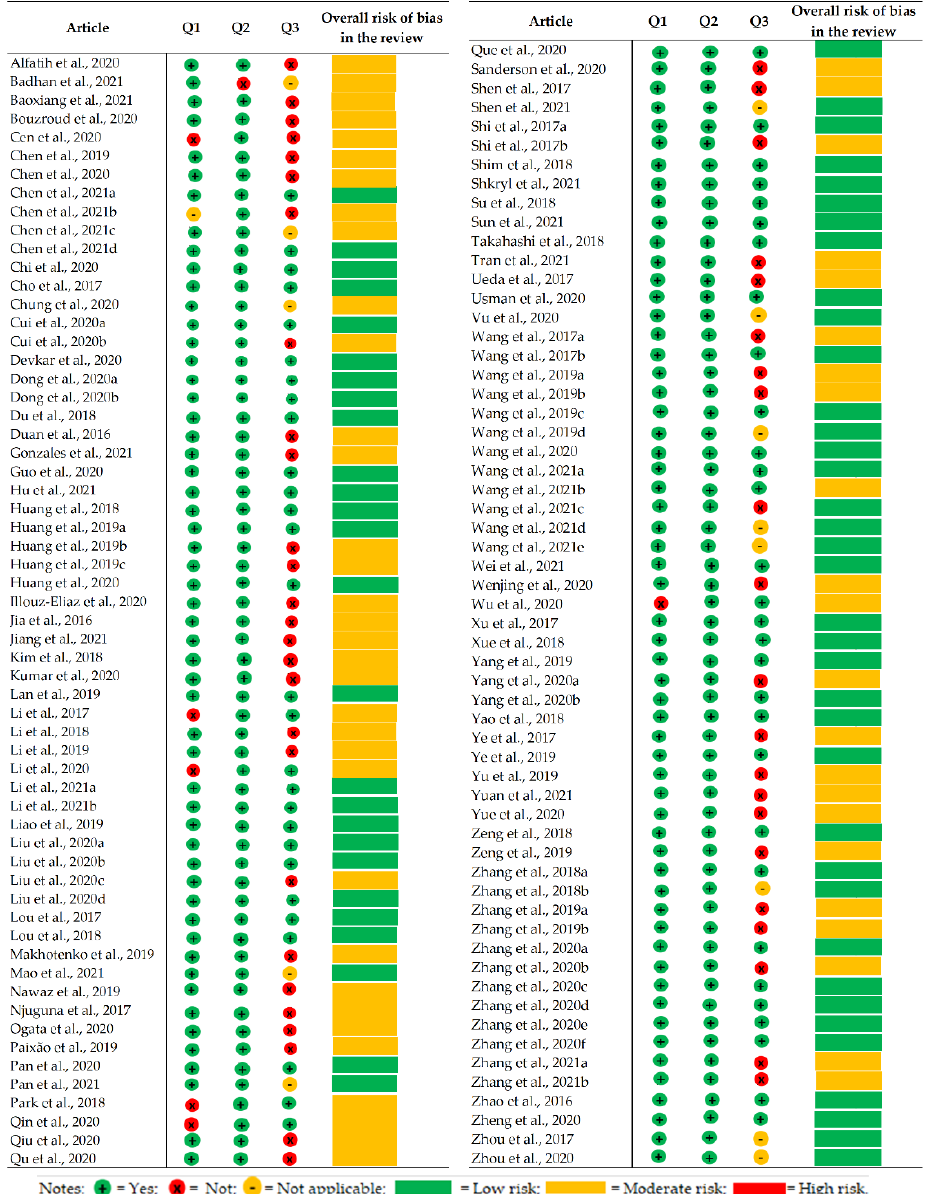
Figure 11. Summary of the risk of bias assessment in the articles on CRISPR/Cas technology used for gene editing for tolerance to abiotic stresses published in the last seven years.